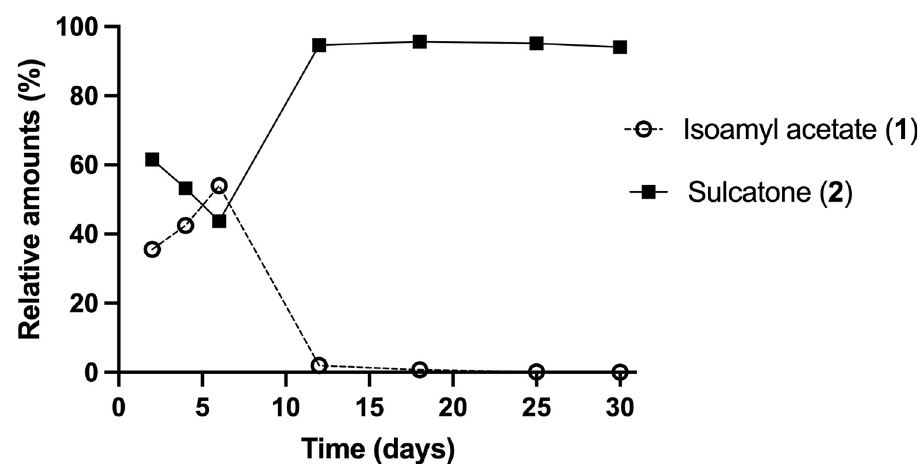
Fig 2. Time course of relative amounts of isoamyl acetate (1) and sulcatone (2) and produced in an ER culture over time.